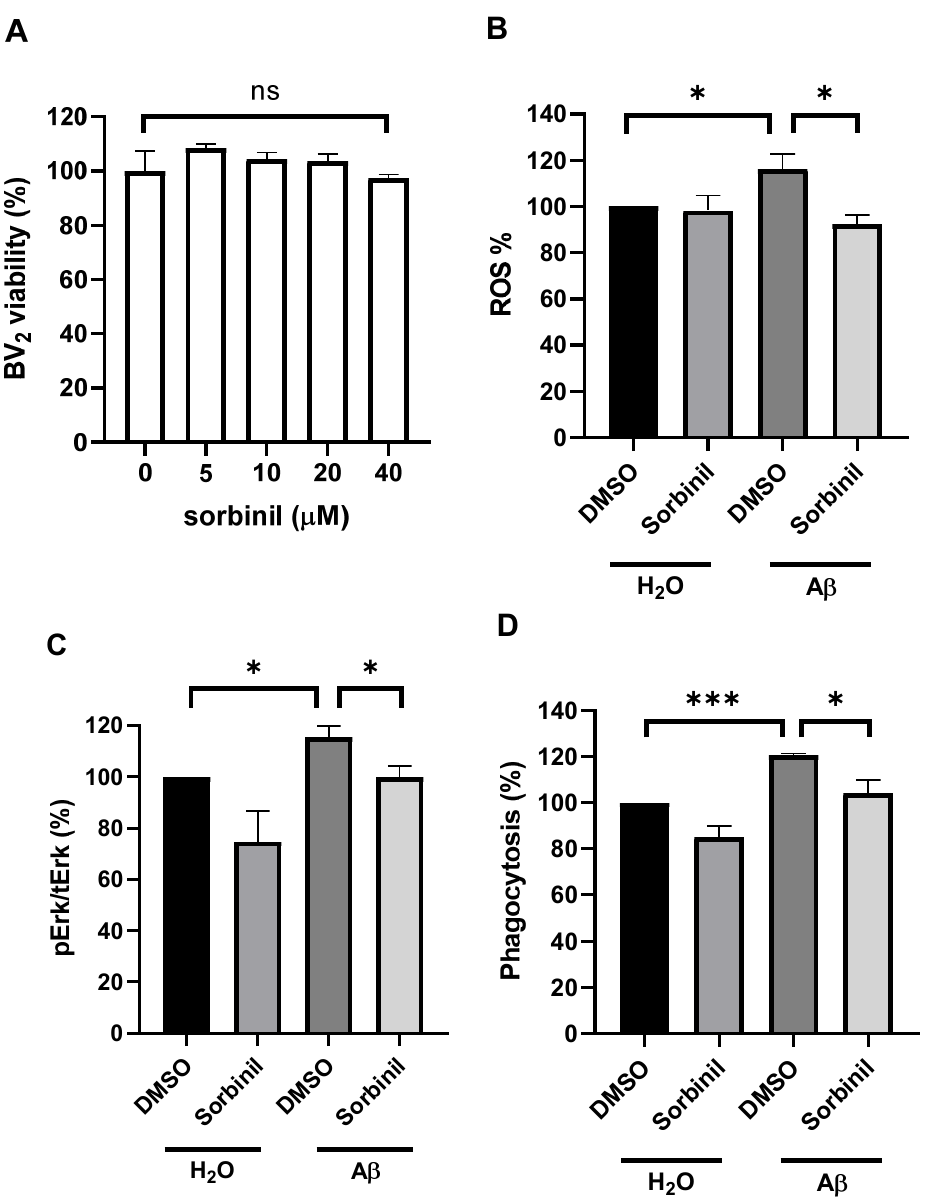
Figure 2. AR inhibition reduces reactive oxygen species (ROS) production and ERK signaling in BV 2 cells. ( A ) Results of MTT cell viability assay of BV 2 cells treated with a range of sorbinil doses. ( B ) ROS assay results for BV 2 cells pretreated with sorbinil (10 µ M, 1 h) and incubated with β -amyloid (A β ; 10 µ M, 1 h). ( C ) Phospho-ERK production in BV 2 cells pretreated with sorbinil (10 µ M, 1 h) and treated with A β (10 µ M, 24 h) was measured by Western blot. ( D ) Phagocytosis assay results for BV 2 cells pretreated with sorbinil (10 µ M, 1 h) and treated with A β (10 µ M, 1 h). DMSO and H 2 O represent negative controls. Data shown are means ± SEM (N = 5). * p < 0.05, *** p < 0.005, ns = not signif ‐ icant.